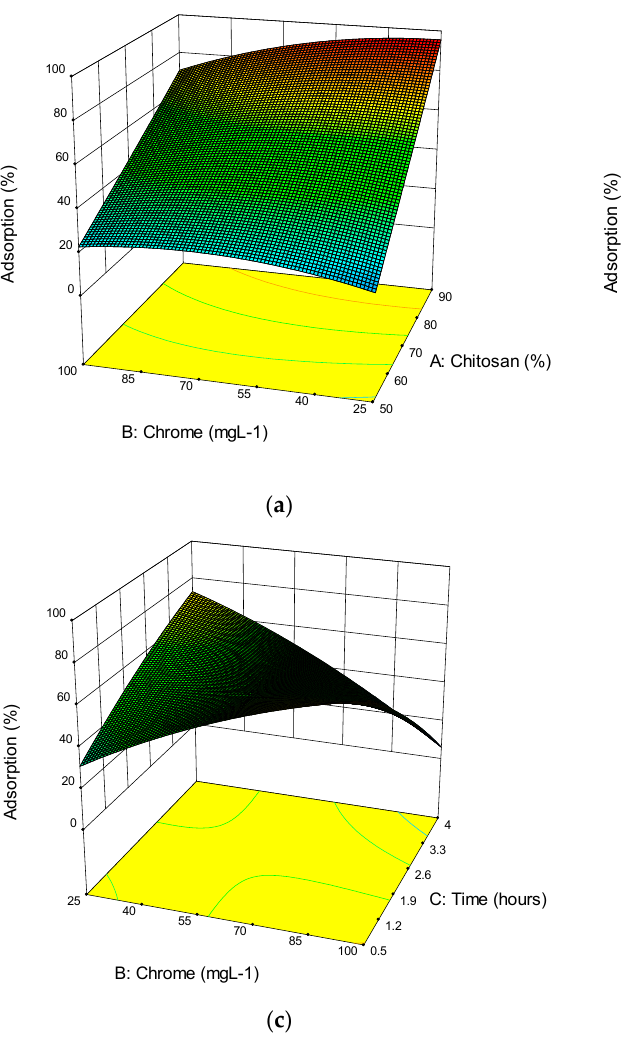
Figure 3. Three-dimensional figures for Cr (VI) adsorption ( a ) chitosan vs. chrome at 2.3 h adsorption time, ( b ) time vs. chitosan at 62.5 mg/L. Initial concentration of Cr(VI) (mg/L), and ( c ) chrome vs. time at 69/31% vol chitosan/resole concentration volume (%).